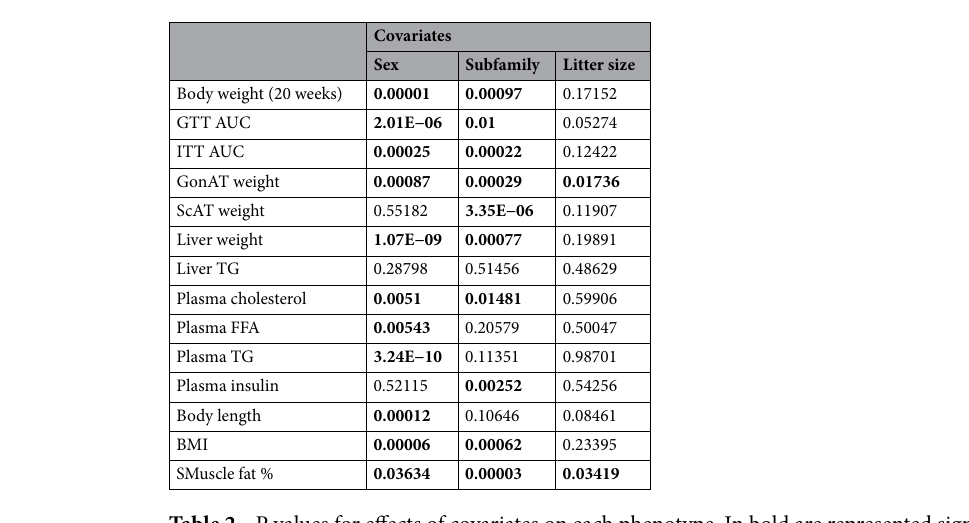
Table 2. P values for effects of covariates on each phenotype. In bold are represented significant covariates that were included in the model for each trait. gonAT, gonadal adipose tissue; scAT, subcutaneous adipose tissue; Gluc, blood glucose concentration; ITT, insulin tolerance test; GTT, glucose tolerance test; AUC, area under the curve; FFA, free fatty acids; TG, triglycerides; BMI, body mass index; SMuscle fat %, skeletal muscle fat